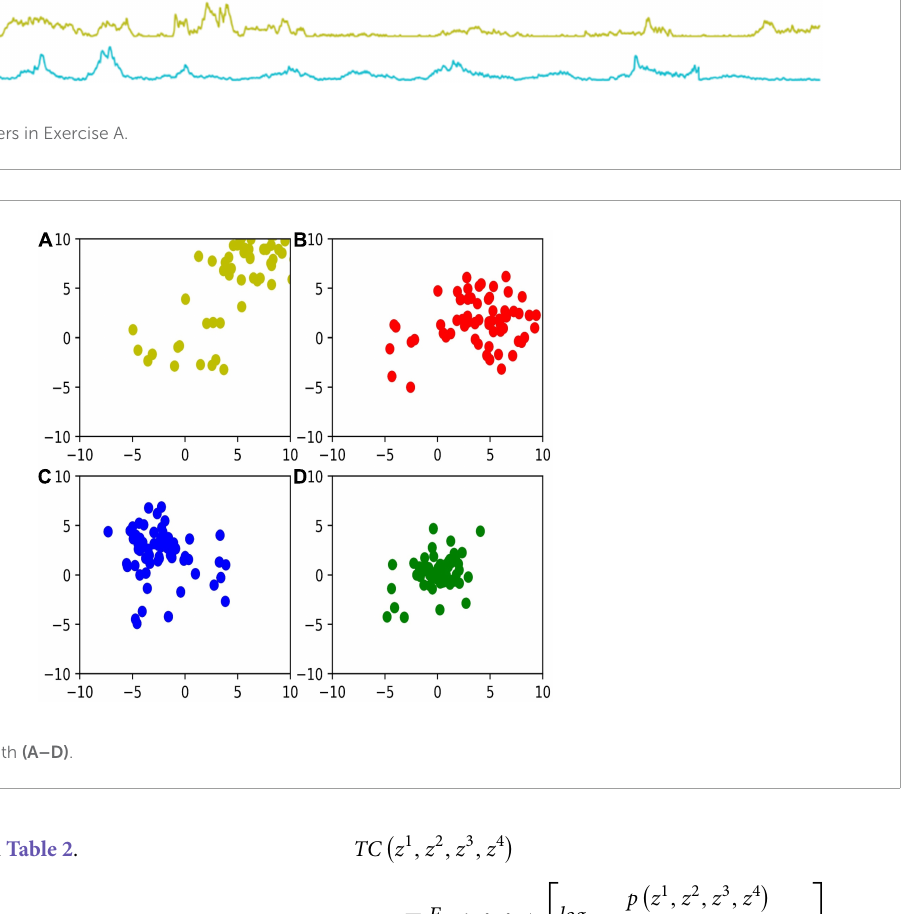
Detail parameters are listed in Table 2